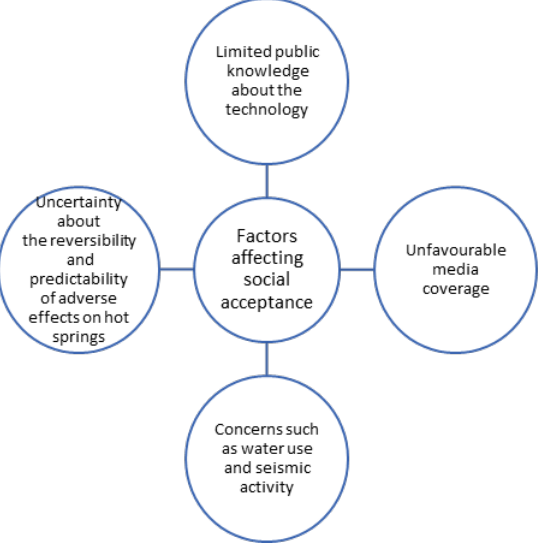
Figure 1. Factors impacting social acceptance of geothermal projects (adopted by [22]) .